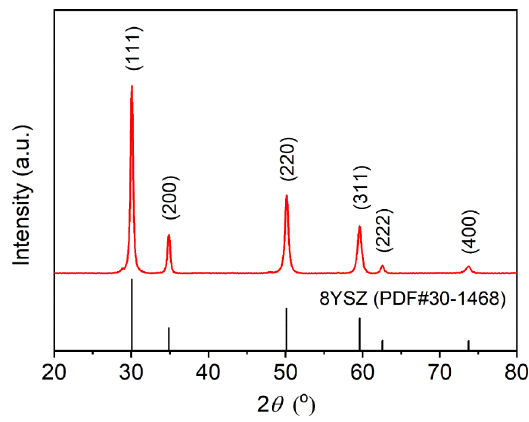
Fig. 1 XRD pattern of the commercial 8YSZ powders.